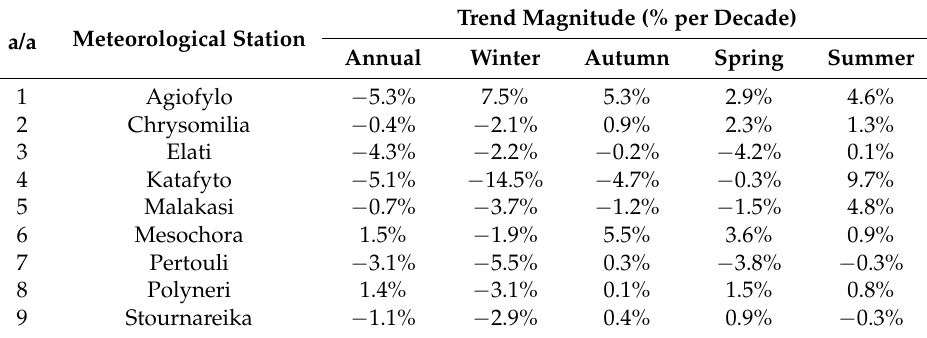
Table 4. Trend magnitude (%) per decade using Sen’s slope method.